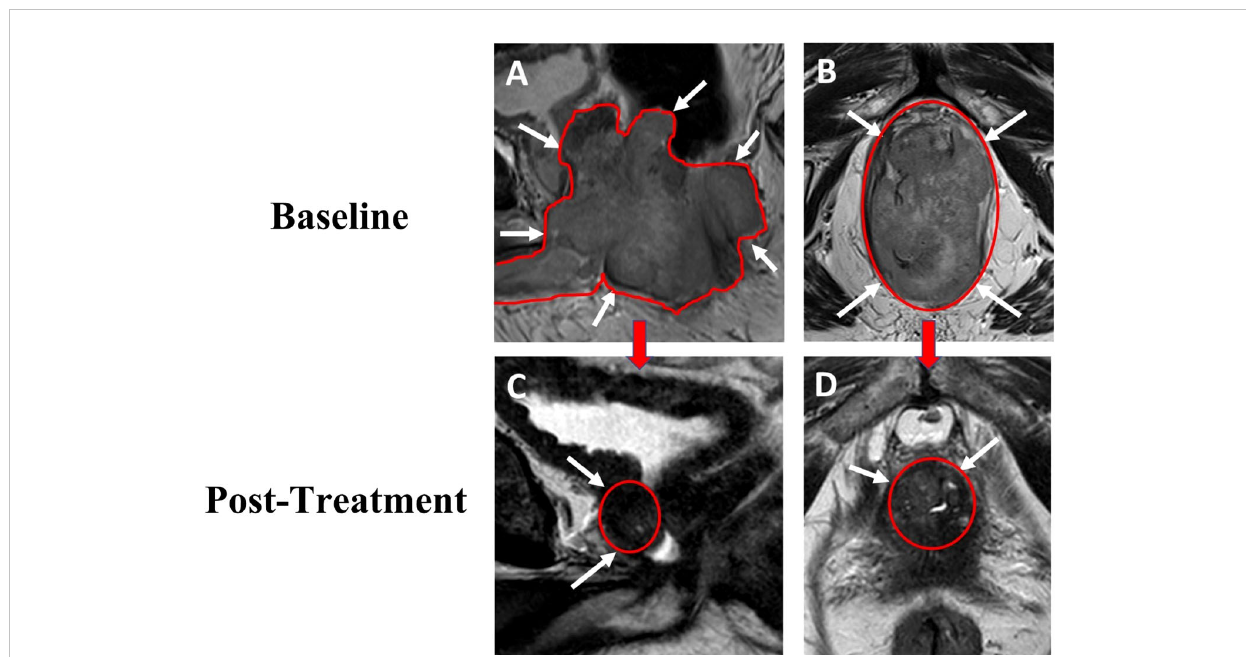
FIGURE 1 69-year-old male with advanced prostate cancer. Baseline sagittal (A) and axial (B) T2W MRI performed after transurethral resection show a large mass (total lesion volume of 282cc) occupying the whole prostate with rectum, bladder with diffusion restriction on ADC map. Post-treatment follow up sagittal (C) and axial (D) T2W MRI show a gradual decrease in size of the lesion (total lesion volume 11.4cc) without evidence of rectum and bladder involvement. T2W, T2 weighted image; ADC, apparent diffusion coef fi